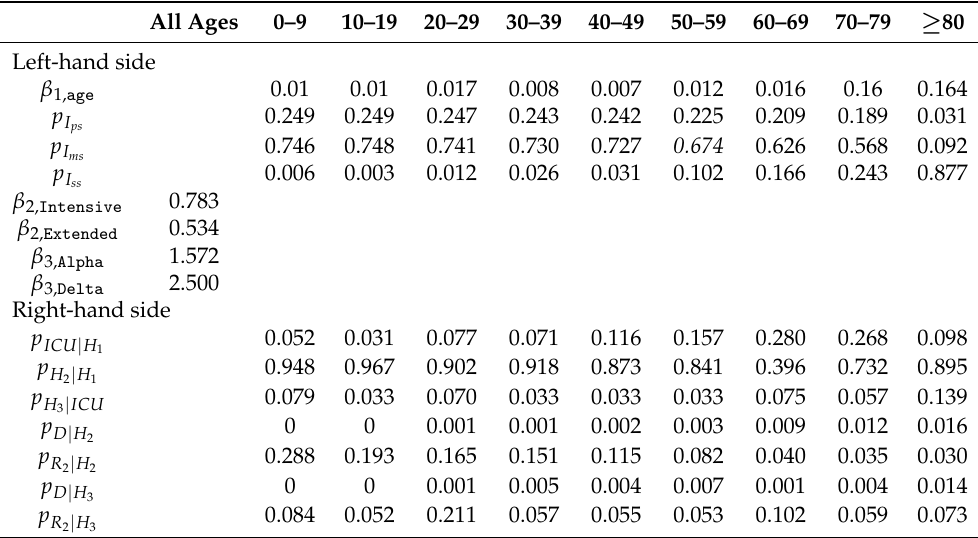
Table 2. Estimated parameters of the left- and right-hand parts of the model (extracted and modified from